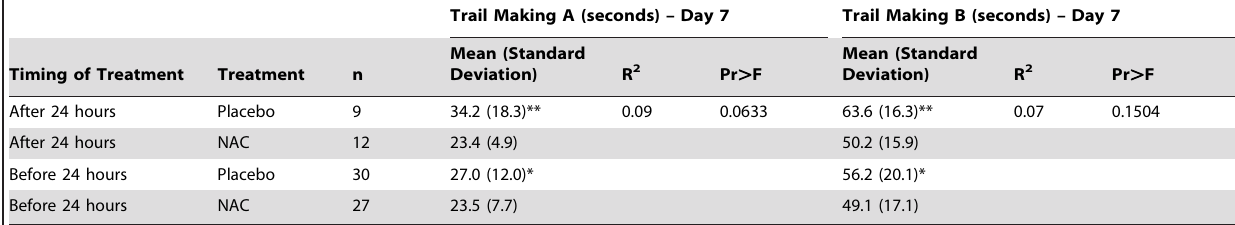
Table 7. Neuropsychological tests: TMT at Day 7.